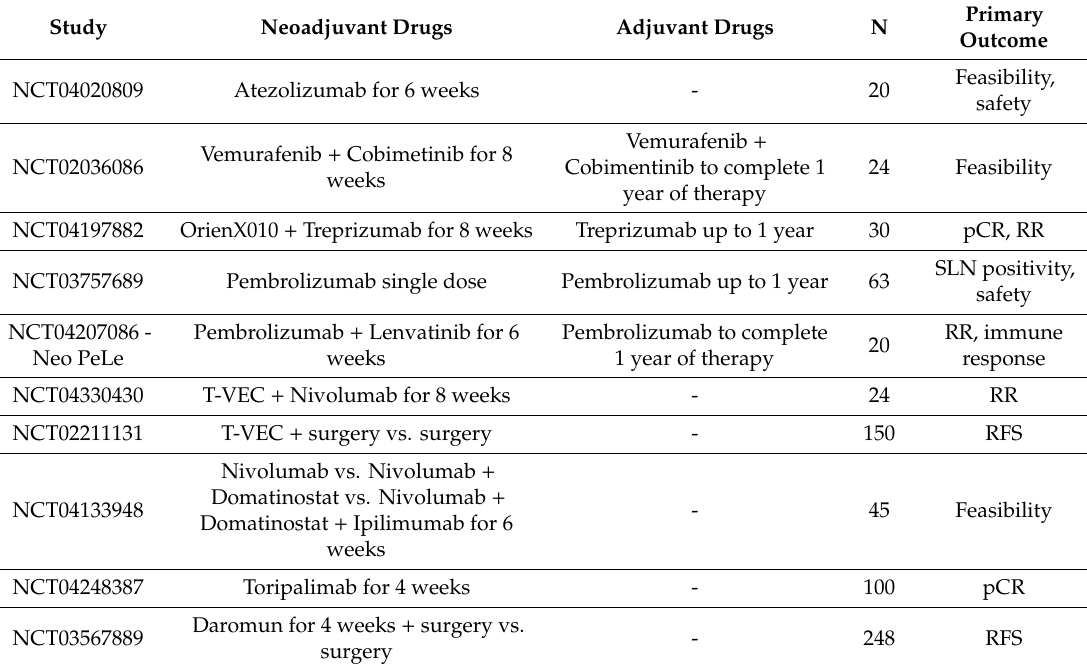
Table 2. Ongoing neoadjuvant trials for stage III